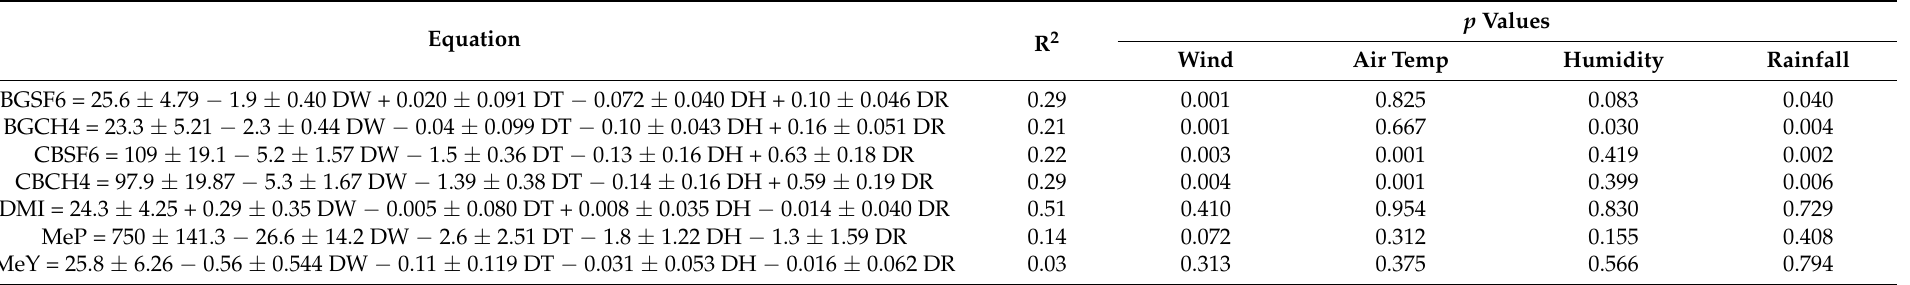
Table 3. Influence of mean daily wind speed (DW, m/sec), mean daily air temperature (DT, ◦ C), mean daily relative humidity (DH, %) and daily total rain (DR, mm) on concentrations in background gases of SF 6 (BGSF6, ppt) and methane (BGCH4, ppm) and concentrations in breath of SF 6 (CBSF6, ppt) and of methane (CBCH4, ppm), as well as dry matter intake (DMI, kg/day), calculated methane production (MeP, g/day) and methane yield (MeY, g/kg